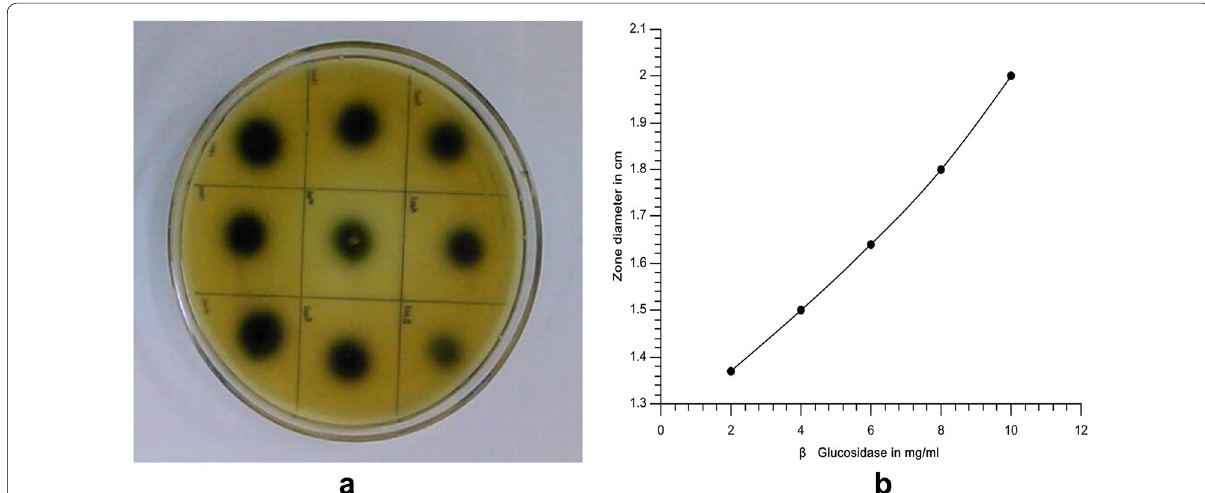
Fig. 3 Standard curve on esculin gel diffusion assay for β-glucosidase. a Different concentrations of standard β-glucosidase enzyme from sweet